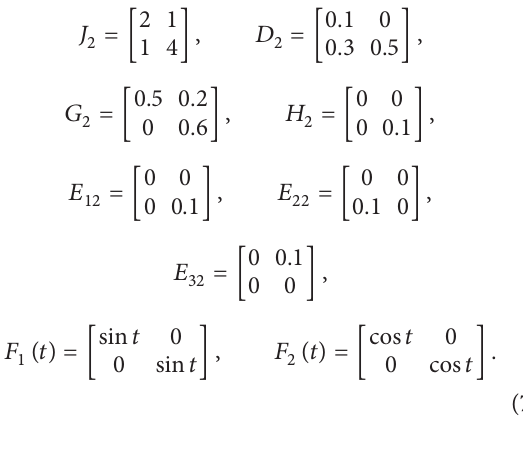
Figure 1: Switching signal.